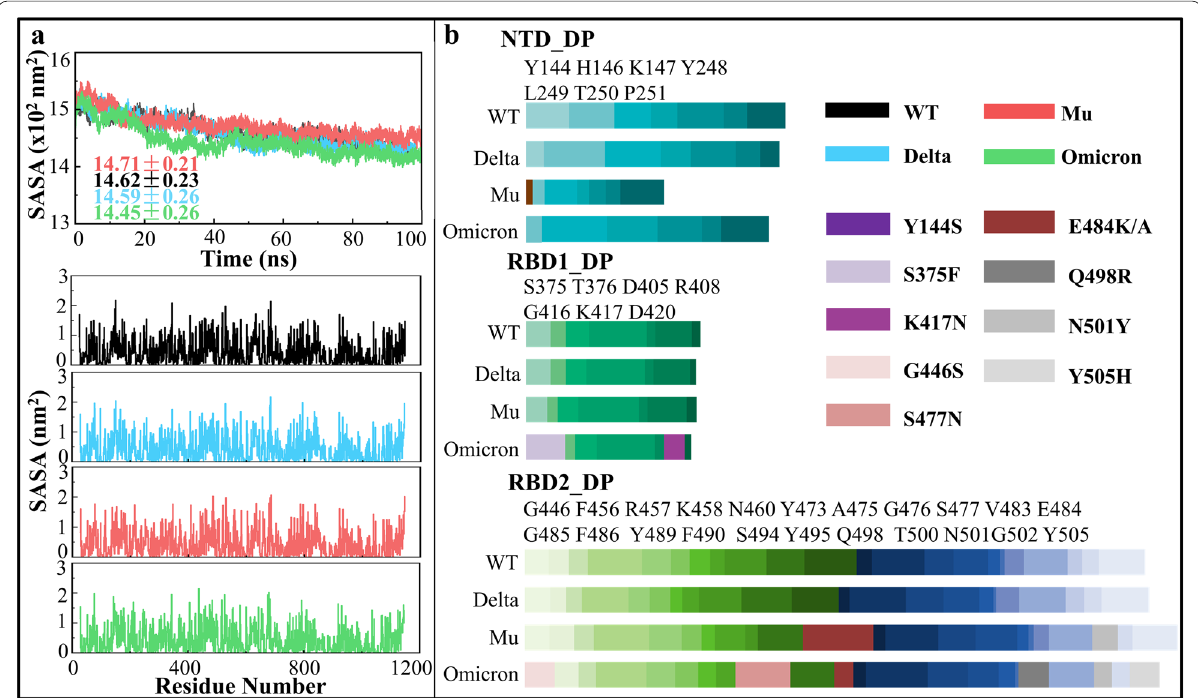
Fig. 4 The SASA analyses of the WT, Delta, Mu and Omicron systems. a SASA changes at the overall and residual levels; b domain-specific SASA for DPs in the NTD, RBD1 and RBD2